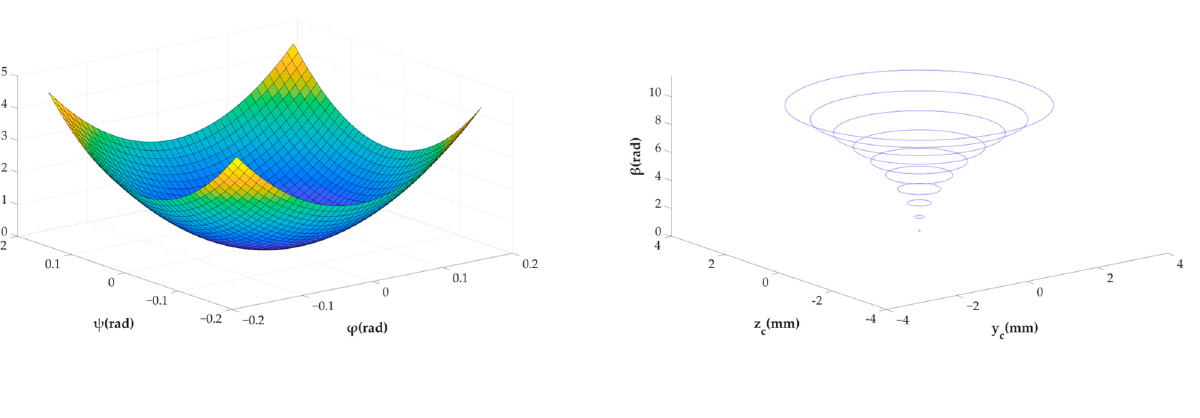
Figure 15. ( a ) The offset between the O 1 - and X 0 -axes; ( b ) The relation between β , y c and z c .